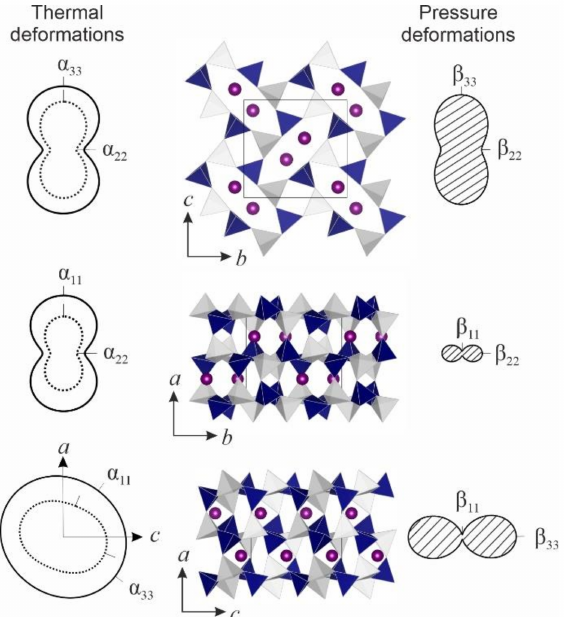
Figure 2. Crystal structure of slawsonite with the section of thermal expansion and pressure com- pression coefficients. AlO 4 and SiO 4 tetrahedra are given in grey and blue, respectively. Sr atoms are presented as purple spheres. Thermal expansion and pressure compression coefficients along the principal axes of deformations tensors are labeled by α and β ,